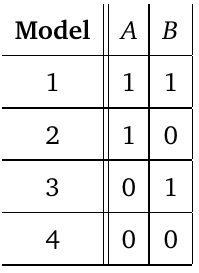
Table 3: Values of the parameters A and B